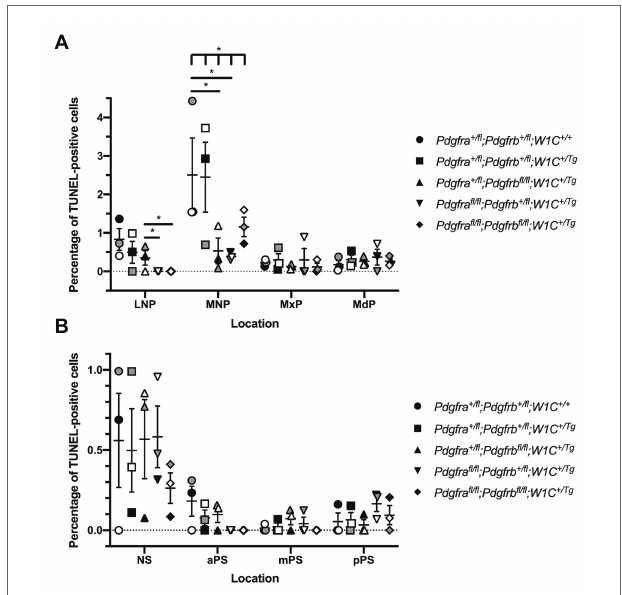
FIGURE 7 | Neither PDGFR α nor PDGFR β signaling plays a critical role in cNCC-derived facial mesenchyme survival during mid-gestation. (A) Scatter dot plot depicting the average percentage of terminal deoxynucleotidyl transferase-mediated dUTP nick end labeling (TUNEL)-positive cells per embryo in the nasal processes and facial prominences across five genotypes at E10.5. Data are presented as mean ± SEM. * p < 0.05. Shades correspond to independent experiments across three biological replicates. LNP, lateral nasal process; MNP, medial nasal process; MxP, maxillary prominence; and MdP, mandibular prominence. (B) Scatter dot plot depicting the average percentage of TUNEL-positive cells per embryo in the nasal septum (NS) and secondary palatal shelves across five genotypes at E13.5. Data are presented as mean ± SEM. Shades correspond to independent experiments across three biological replicates. NS, nasal septum; aPS, anterior secondary palatal shelves; mPS, middle secondary palatal shelves; and pPS, posterior secondary palatal shelves.